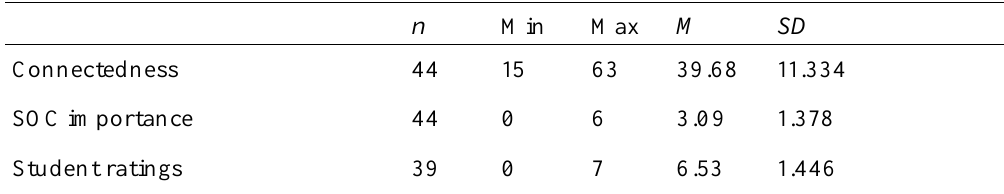
Descriptive Statistics for Iteration